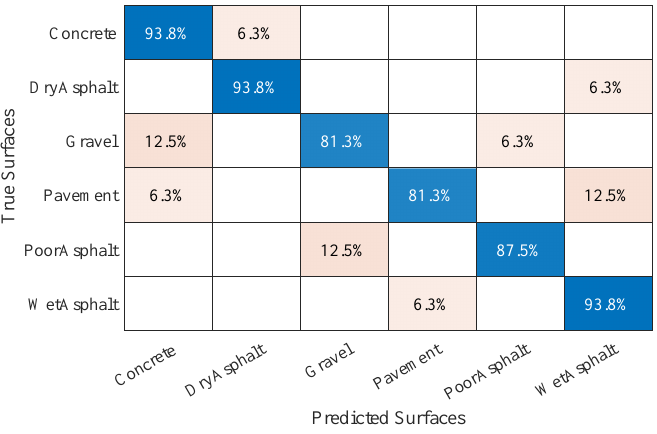
Figure 10. Confusion chart corresponding to estimation rate achieved in six-surface experiment.